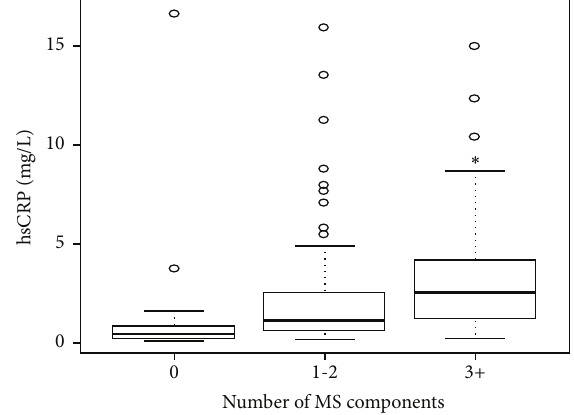
Figure 2: Mean levels of high sensitive C-reactive protein by number of metabolic syndrome components. ∗ 𝑃 = 0.04 versus 0 MS components. hsCRP: high sensitivity C-reactive protein; MS: metabolic